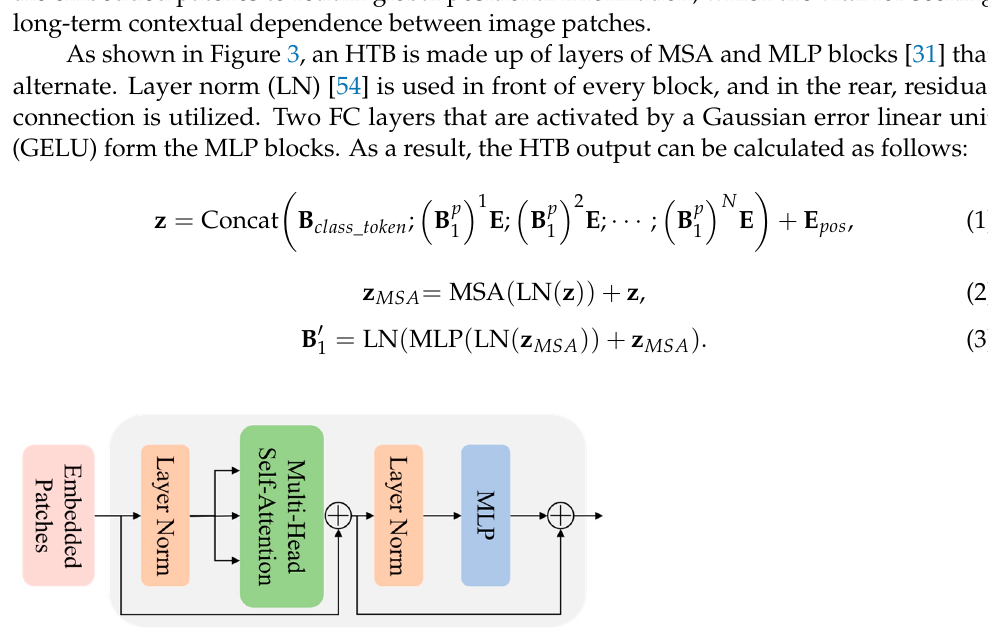
Figure 3. Specific details of the hierarchical transformer block (HTB). HTB uses Multiheaded Self- attention (MSA) and Multilayer Perceptron (MLP) Blocks in alternating layers. Each block has a layer norm (LN) in the front, and a residual connection in the back.